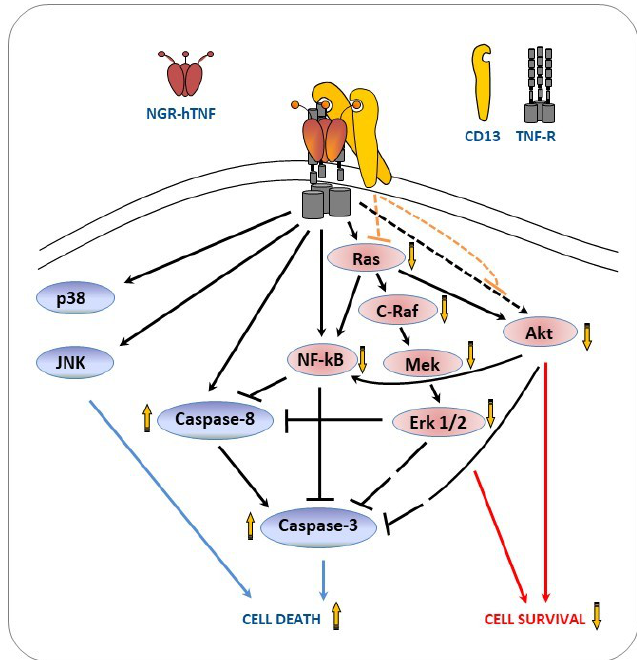
Figure 7. Interaction between TNFR and CD13 cell signaling. The proteins in blue circles are stress or cell death related, while the proteins in orange circles are pro-survival factors. The black lines indicate activator (arrow head) or inhibitor (not arrow head) effects triggered by the TNFR, or the interactions between the target proteins. The orange lines show the interference of the CD13 on the cell signaling induced by TNFR. The dotted lines indicate that the mechanism of action is not fully elucidated. The vertical short orange arrows indicate an increase (upward pointing arrow) or decrease (downward pointing arrow) in the activation induced by NGR-hTNF in comparison with hTNF. The resulting biological activities are indicated by blue (cell death) and red (cell survival) arrowed lines.